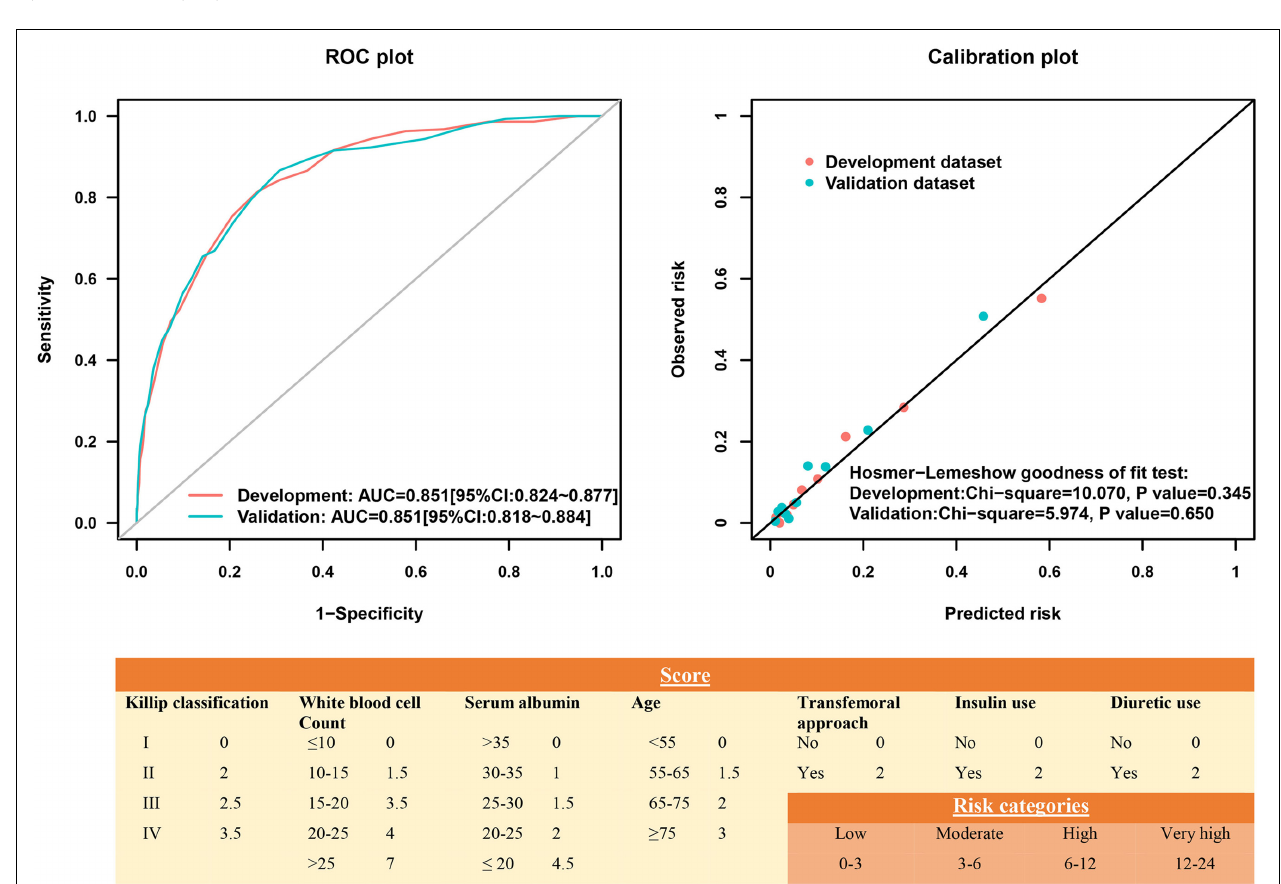
FIGURE 2 | Receiver operating characteristic curve and calibration plot of the risk score for post-acute myocardial infarction (AMI) infection.